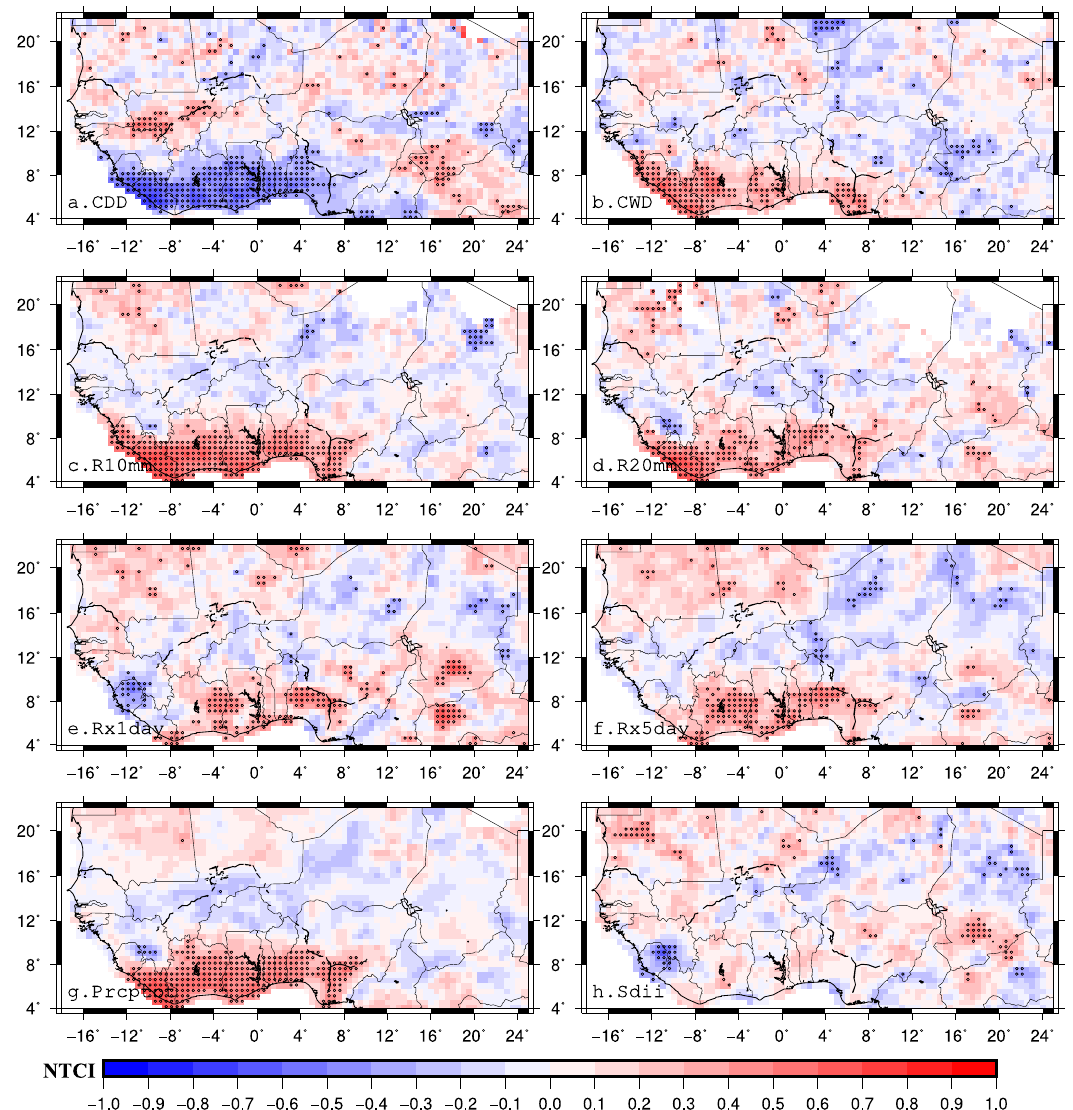
Figure 8. Correlation patterns between NCTI and extreme precipitation indices. Tipping points represent significant correlation areas using EDOF. ( a ) CDD, ( b ) CWD, ( c ) R10mm, ( d ) R20mm, ( e ) Rx1day, ( f ) Rx5day, ( g ) Prcptot and ( h )